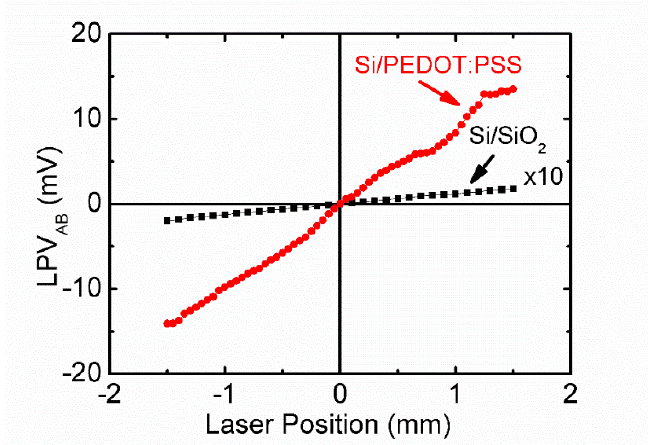
Figure 2. LPV AB as a function of laser position in ( a ) Si/SiO 2 structure (black square dotted line) and ( b ) Si/PEDOT:PSS structure (red circle dotted line).